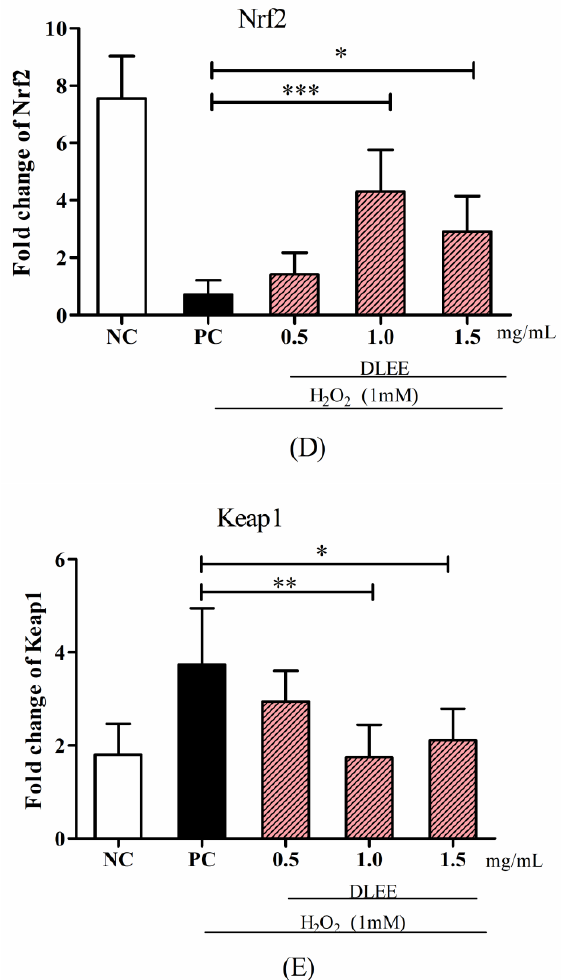
Figure 3. The mRNA levels of antioxidant enzymes and proteins. ( A ) GSH-PX, ( B ) CAT, ( C ) GR, ( D ) Nrf2, and ( E ) Keap1. NC, negative control group without any treatments; PC, H 2 O 2 -induced positive control group (1 mM); different concentrations of DLEE (0.5, 1.0, or 1.5 mg/mL) were added for 2 h as pretreatment along with H 2 O 2 (1 mM). Data are presented as the means ± SD ( n = 6); *, **, *** represent significant differences with p < 0.05, p < 0.01, p < 0.001,